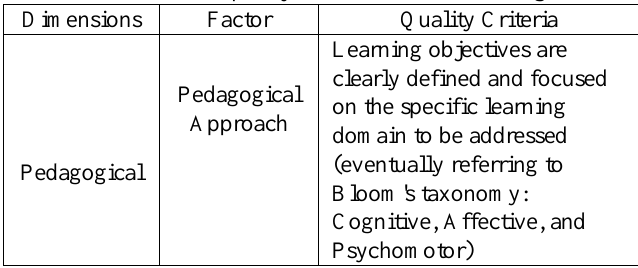
Table 1. General quality criteria for educational